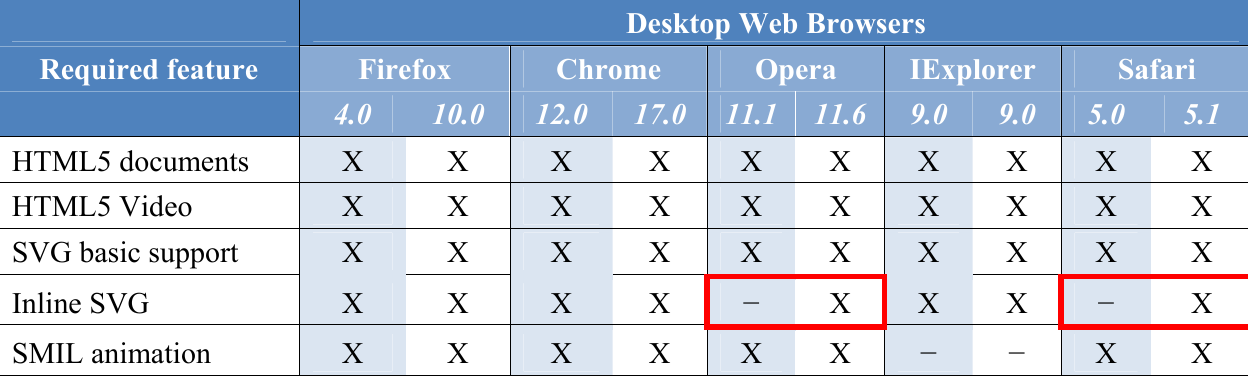
Table 1. Support of the major desktop web browsers for the proposed solution. For each browser, the left-hand column indicates the support provided by the available browser version at the time of our previous study (in mid-2011) and the right-hand column indicates the support provided by the current version of the browser (in early